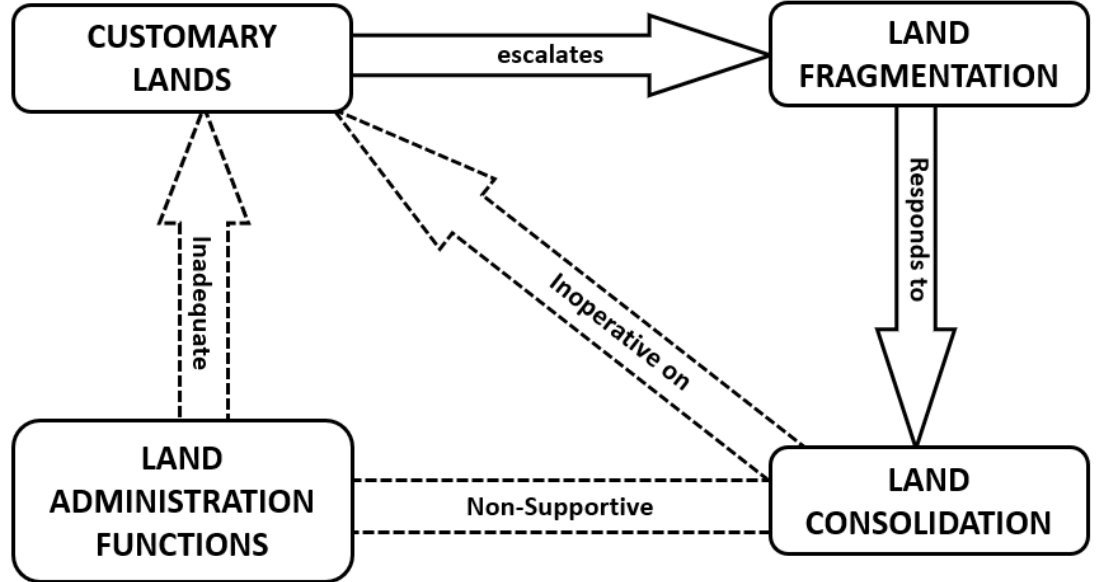
Figure 1. Conceptual framework showing the gaps to be Figure 1 . Conceptual framework showing the gaps to be researched.